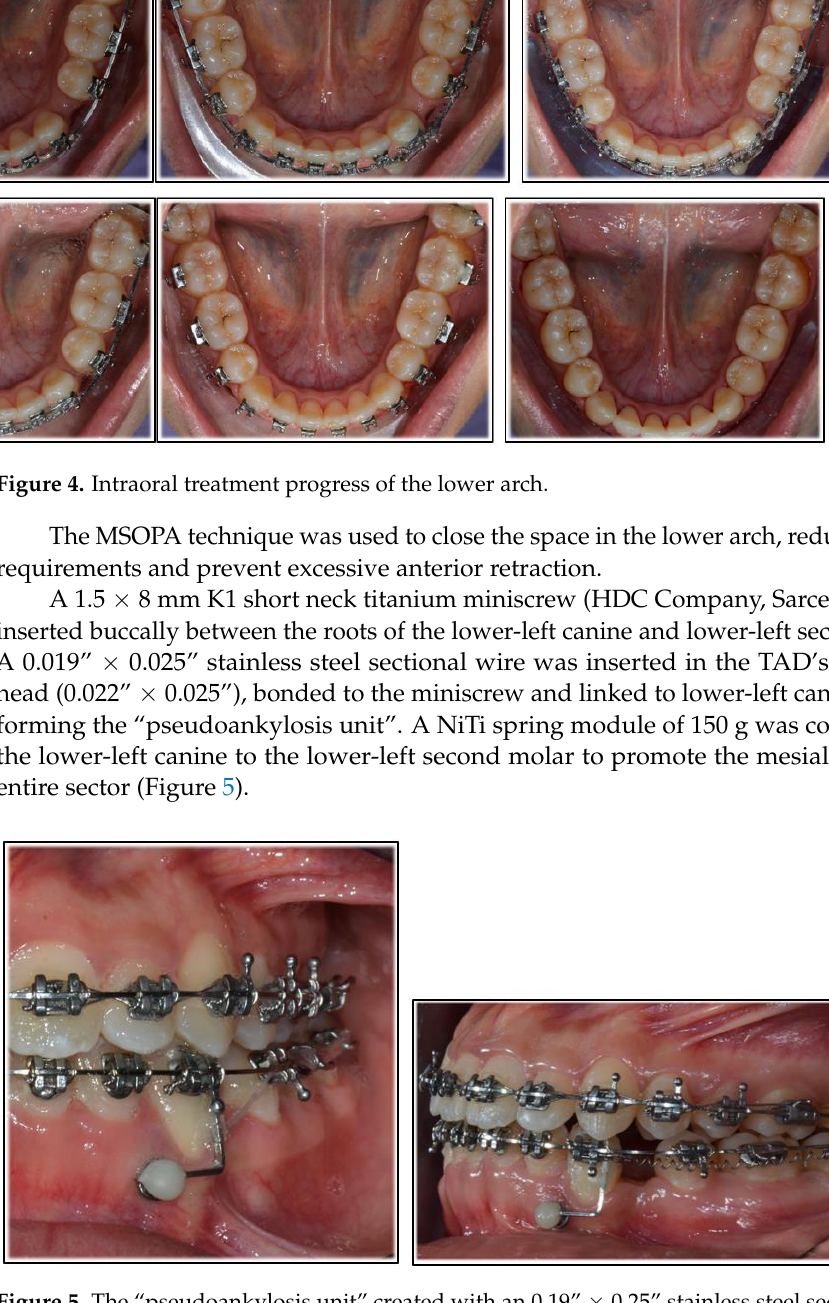
Figure 5. The “pseudoankylosis unit” created with an 0.19” × 0.25” stainless steel sectional inserted in the TAD and linked to the lower left canine. A NiTi spring module connected from the lower canine to second molar to promote mesialization.